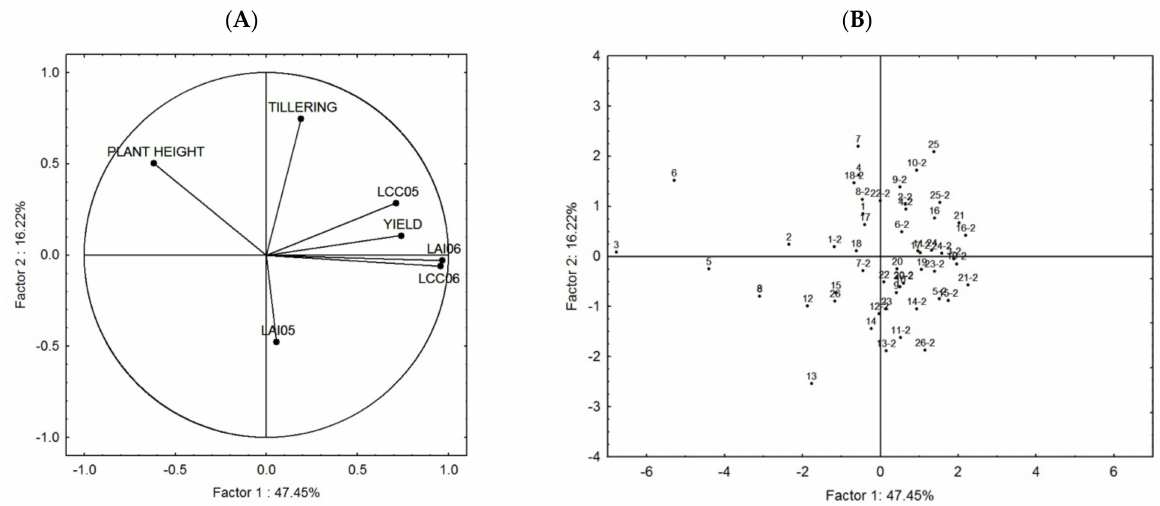
Figure 11. PCA results with 7 traits, LAI05, LAI06, LCC05, LCC06, yield, tillering, and plant height, and both CVTs. The distribution between the traits ( A ) and the genotypes ( B ) within the two main components (Factor 1 and Factor 2) is visualised. The numbers in ( B ) are the genotypes’ codes, the ones without a suffix are from CVT1, and suffix-2 are from